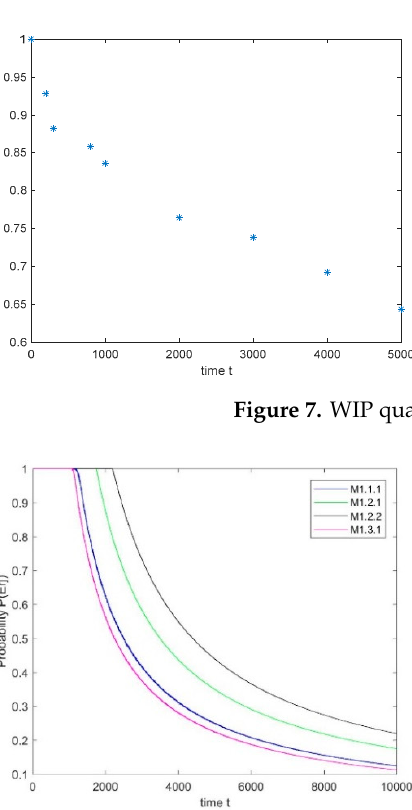
Figure 8. Probability of machines without failure of main spindle and cam.